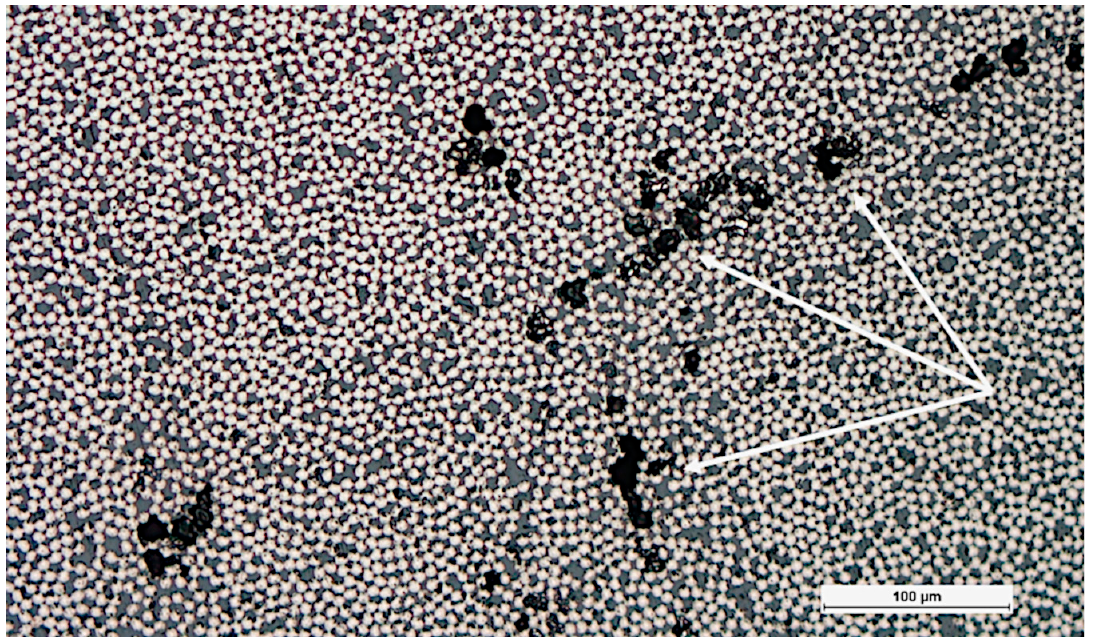
Figure 6. Optical micrograph showing pores (marked with white arrow).